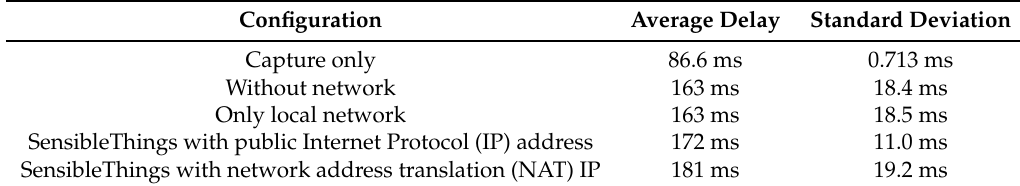
Table 1. Summary of all